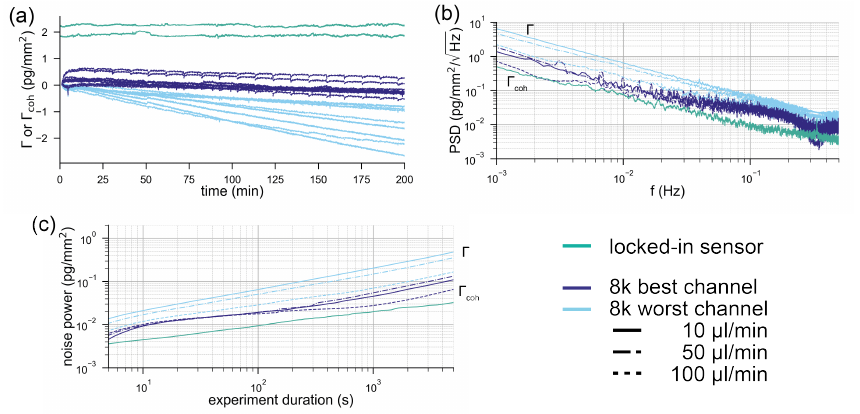
Figure 4. Comparison of the noise performance of a state-of-the-art referenced refractometric biosen- sor with a spatially locked-in diffractometric sensor: ( a ) typical baselines of the locked-in diffracto- metric readout channel (green) extracted from two molographic spots and the response of the best (dark blue) and the worst channel (light blue) from the eight channels of a Biacore 8k+ instrument. The displayed response is the difference between flow cell 1 and flow cell 2 (referenced binding trace). In a Biacore 8k+, each of the eight channels has two flow cells operated in parallel and the referencing between two flow cells is considered crucial in high-performance measurements. In total, nine baselines are shown (three different flow rates and triplicates for each experiment). The unit for the molography traces is the coherent surface mass density, whereas for the Biacore system, it is surface mass density. ( b ) Power spectral density of the binding traces shown in ( a ) the average power spectral density of the triplicates for each experiment was computed and